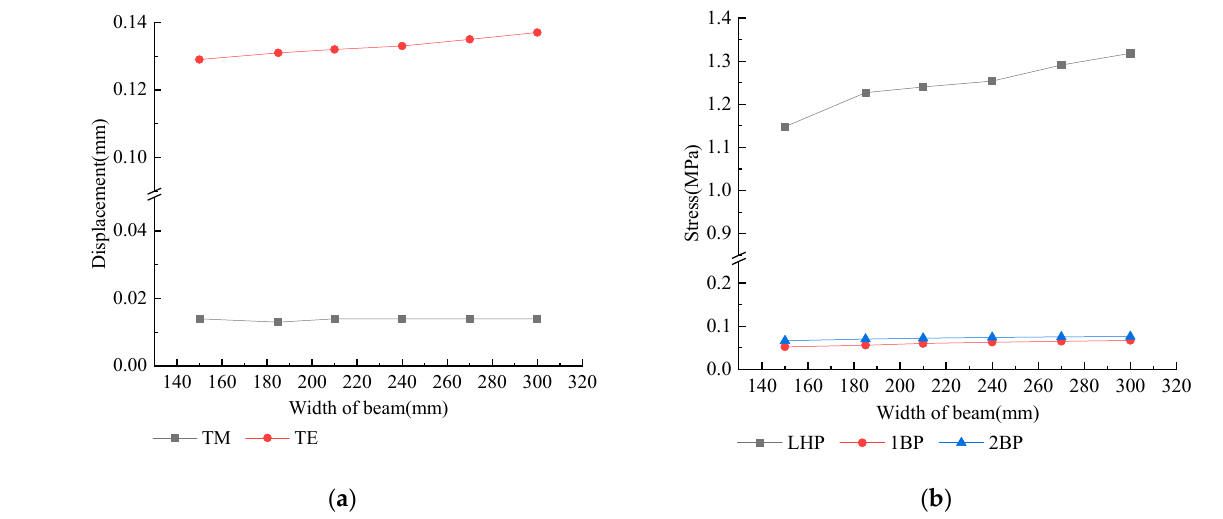
Figure 8. Displacement and stress change trend under different beam widths during construction hoisting period. ( a ) Displacement and ( b ) stress.